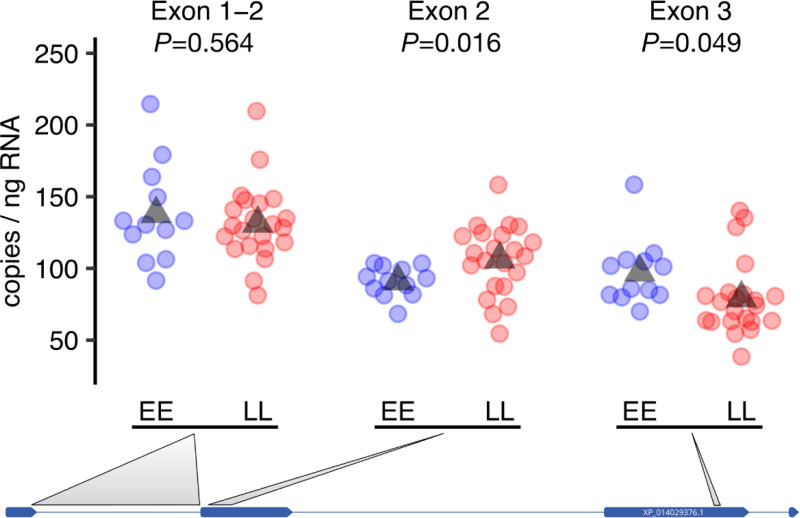
Vgll3 expression differences in immature testes using three RT-ddPCR assays in different vgll3 exons.Individuals with vgll3*EE (blue) and vgll3*LL (red) genotypes show varying levels of expression differences along the vgll3 transcript. Points represent the mean of two replicates per individual sample (triangles; genotype means, P-values; two-sided t-test). Grey lines connect RT-ddPCR assays with the approximate locations of their amplification targets on the NCBI annotated vgll3 transcript model with lines representing introns, rectangles representing exons.